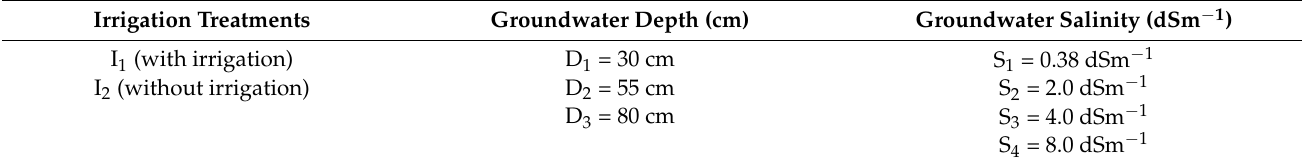
Table 2. Experimental treatments of the irrigation treatments, groundwater depth, and groundwater salinity. Irrigation Treatments Groundwater Depth (cm) Groundwater Salinity (dSm − 1